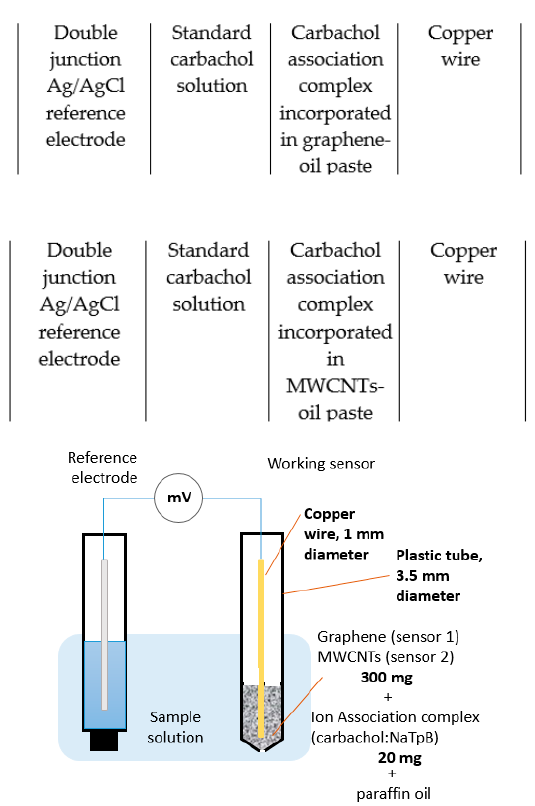
Figure 3. Experimental setup of the proposed sensors.